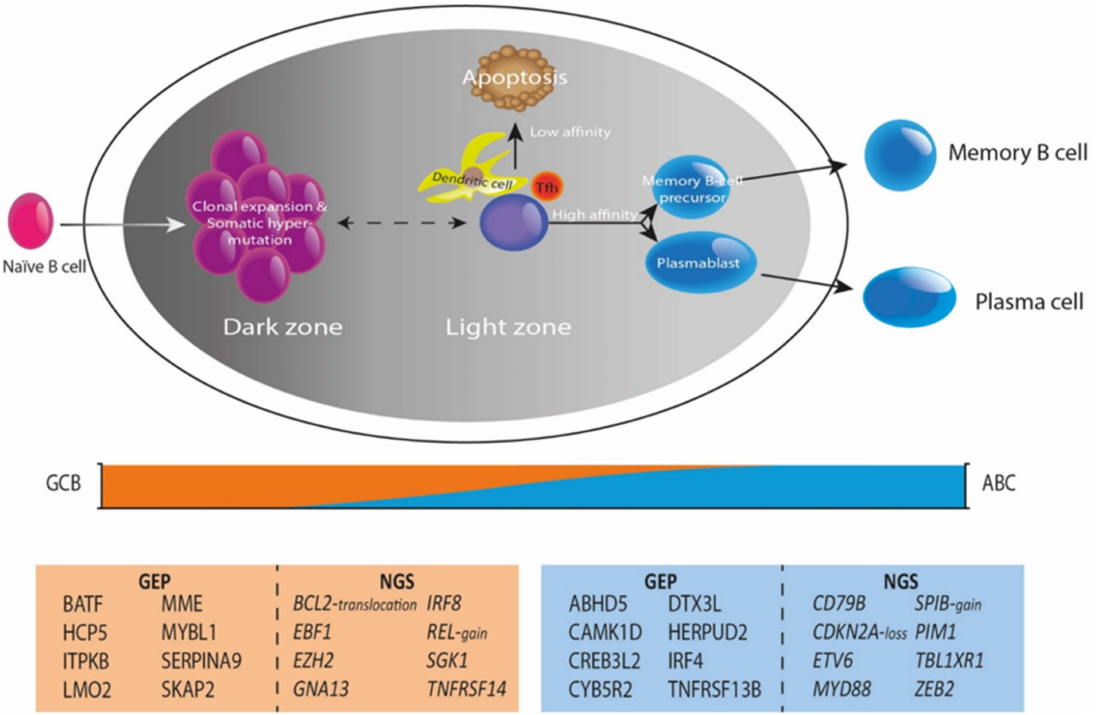
Figure 2. Genetic perspectives of B-cell lymphomagenesis. Under normal physiological circum- stances, the germinal center is crucial for B-cell development and maturation, defining different cellular subtypes and states throughout this continuing process. DLBCL lymphomagenesis shows a GCB subtype in the earlier stages of development and an ABC subtype in later stages, represent- ing COO classification. The COO classification is substantiated by distinct characteristic GEP and mutational profiles between GCB and ABC. This insight shows the importance of combining DNA NGS and GEP in a more multidimensional approach that improves classification and prognostication of